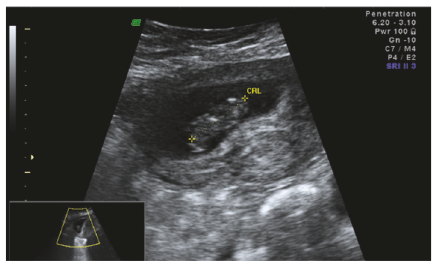
Figure 2: US image of intrauterine pregnancy.